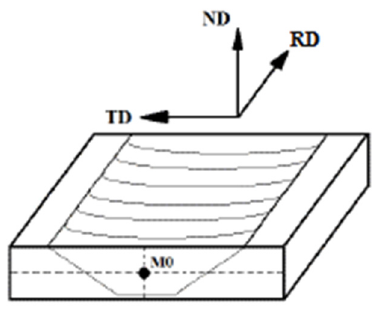
Figure 2. EBSD sampling diagram.